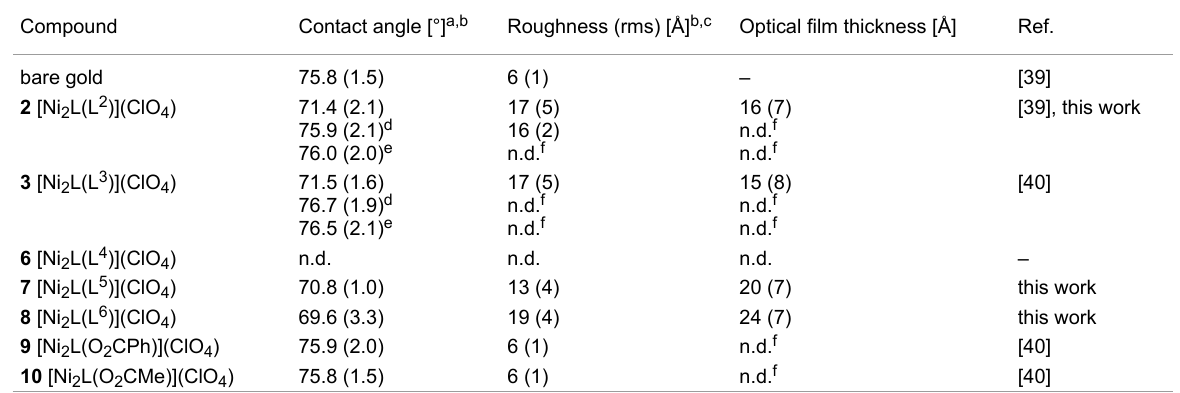
Table 2: Water contact angles, AFM roughness, and optical thickness obtained for Au(111) surfaces modified with various dinickel(II) complexes.